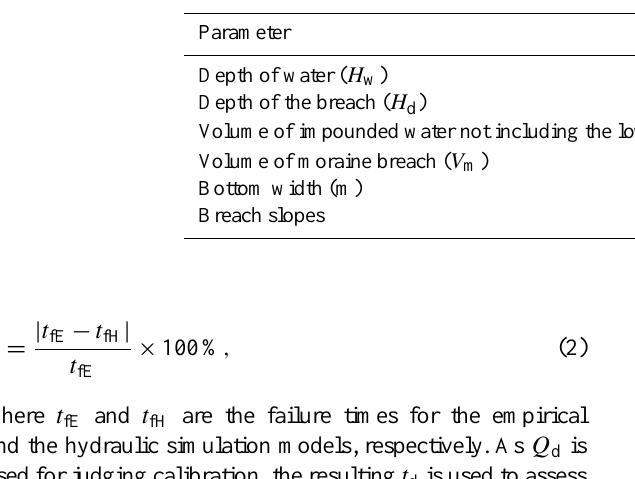
Table 3. Physical parameters for moraine breach models of Lake